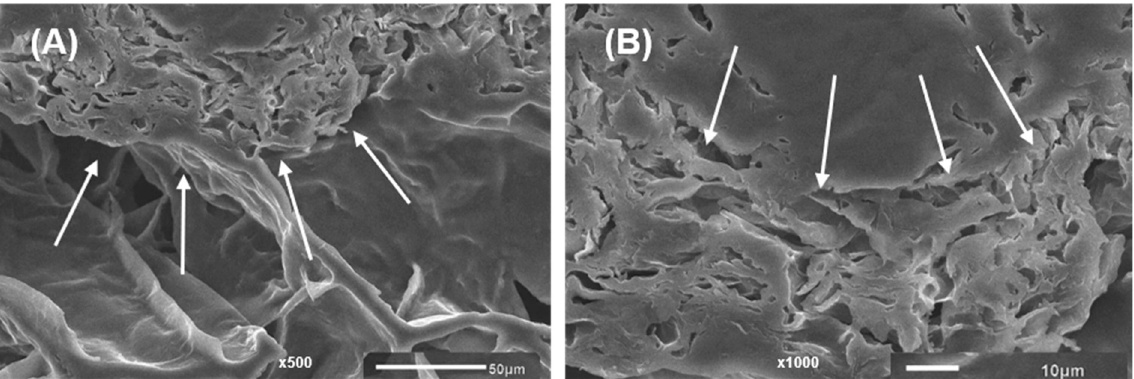
Figure 8. Scanning electron micrographs of the 3D ‐ printed gel containing LA16 ‐ 66 callus at ( A ) mag ‐ nification 500×; scale bar 50 μ m and ( B ) magnification 1000×; scale bar 10 μ m. The arrows indicate ( A ) magnification 500 × ; scale bar 50 µ m and ( B ) magnification 1000 × ; scale bar 10 µ m. The ar- the area of dense folded formation. rows indicate the area of dense folded formation.